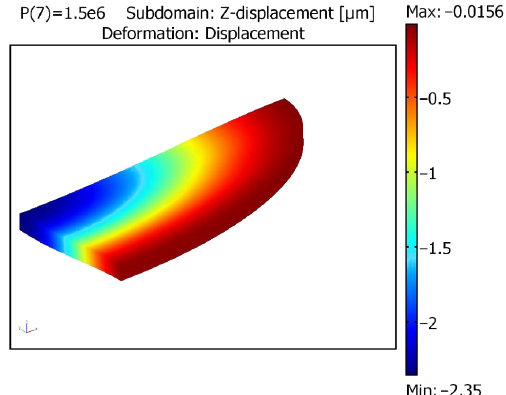
Figure 16. Capacitance–pressure curve of the circular diaphragm in design 1 using FEA.